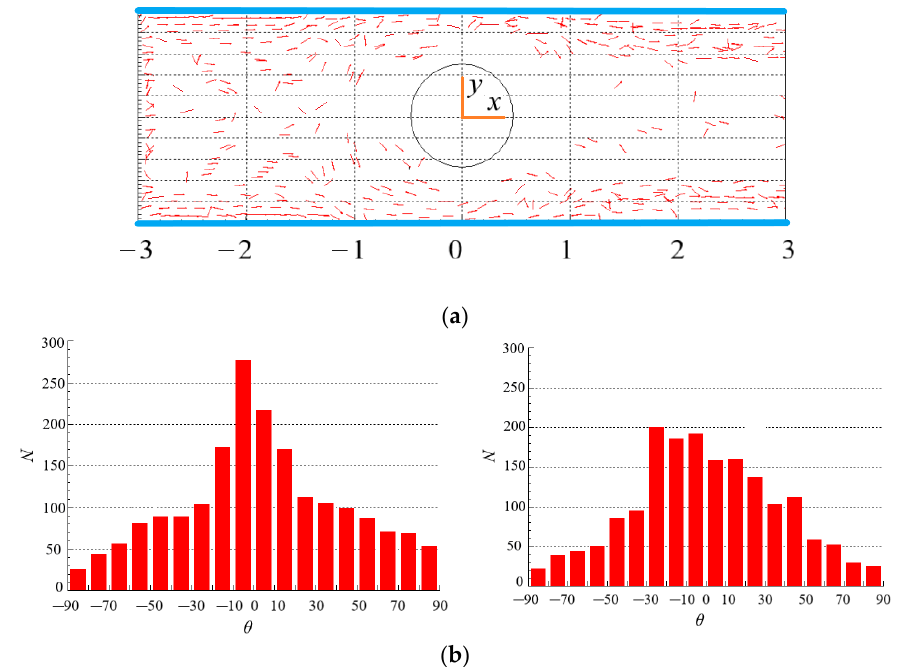
Figure 7. Spatial and orientation distributions of particles at Re = 2 ( n = 1, β = 8). ( a ) spatial distribution. ( b ) orientation distribution: left: contraction flow ( x < 0); right: expansion flow ( x > 0).